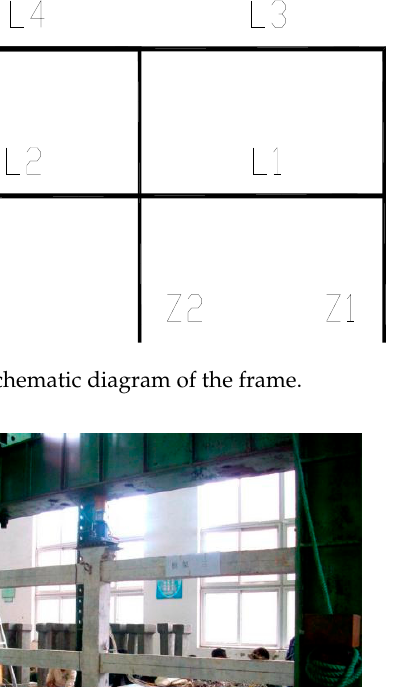
Figure 5. Loading device of the test.